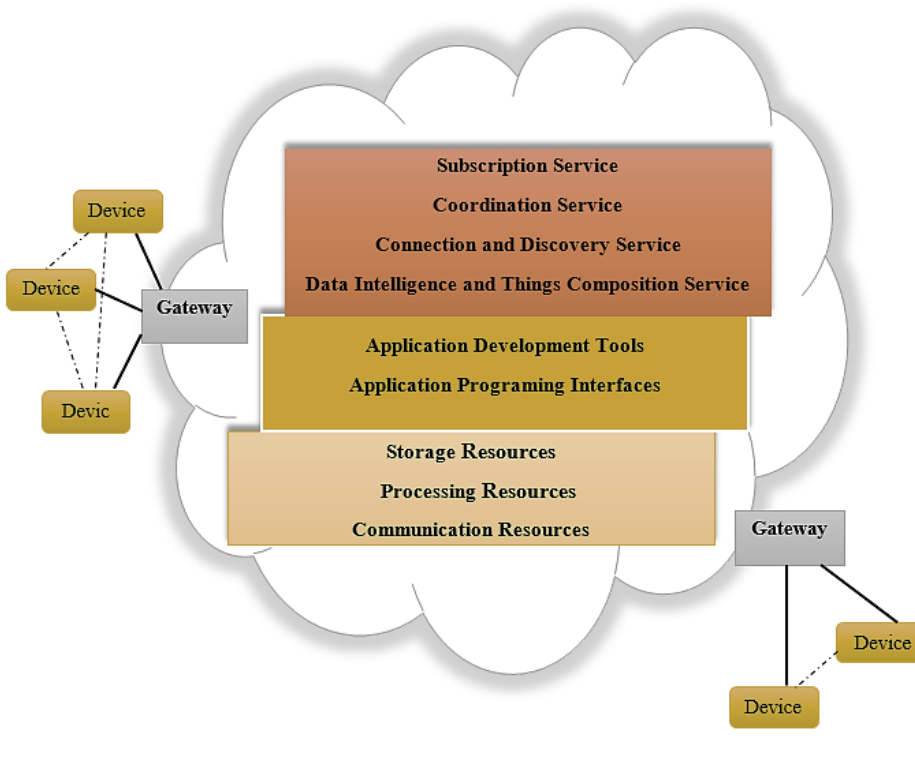
Figure 1. Cloud-based IoT